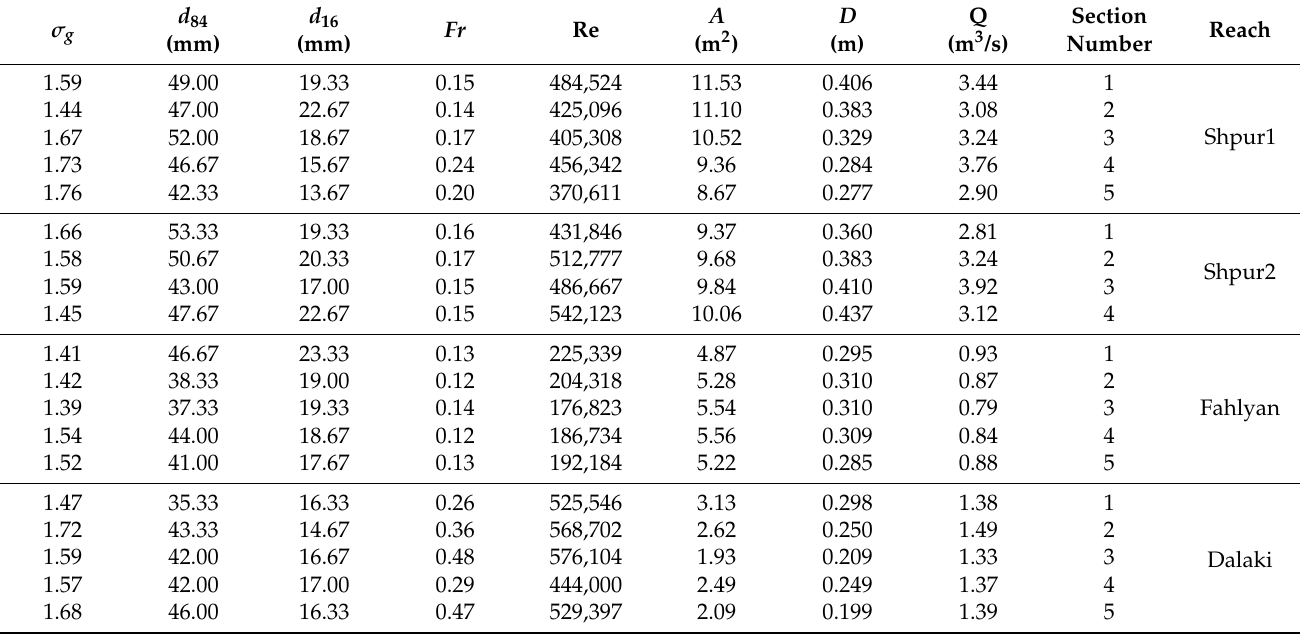
Table 5. Sediment and hydraulic parameters of